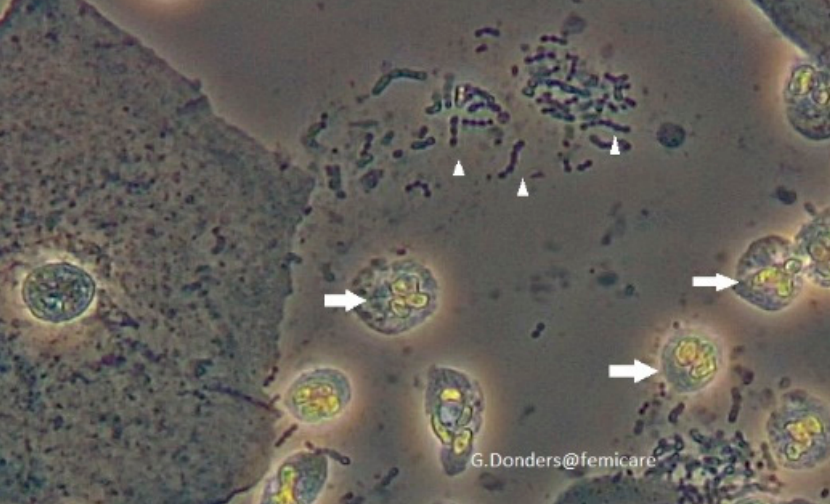
Figure 1. Bedside fresh wet mount microscopy of S. viridians in vaginal fluid. The differential between other streptococci cannot be made on this picture alone, but in a very sick post-op or postpartum patient it is a rapid clue to suspect streptococcal or staphylococcal sepsis and a hint to undertake further sepsis workup and start timely antibiotic coverage. Small arrows: chains of cocci. Normal arrows: leukocytes indicating inflammatory response.